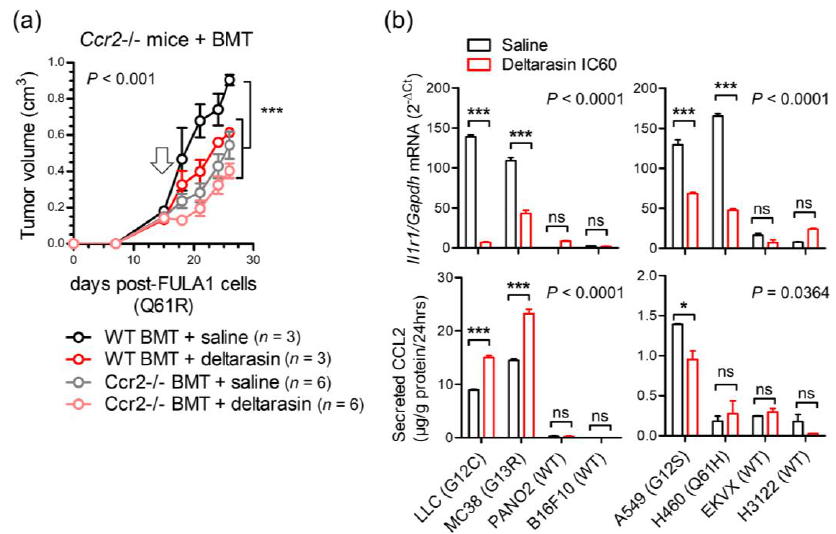
Figure 6. In vivo KRAS-dependence requires myeloid Ccr2 and is abolished by deltarasin treatment via downregulation of IL1R1 expression in KRAS -mutant cancer cells. ( a ) Total-body-irradiated (900 Rad) Ccr2 − / − mice received adoptive BMT from WT or Ccr2 − / − donors (all back-crossed > F12 to the FVB strain). After one month allowed for chimeric bone marrow reconstitution, chimeras received 10 6 syngeneic FULA1 cells ( Kras Q61R ) sc [19]. Daily ip saline or deltarasin (15 mg/Kg in saline) treatments were started when tumors > 100 mm 3 were established (arrow). Data are presented as mean ± SD. p , overall probabilities according to two-way ANOVA; ***: p < 0.001 for the indicated comparisons via Bonferroni post-tests. ( b ) Il1r1/IL1R1 mRNA expression via qPCR (top) and CCL2 protein secretion via ELISA (bottom) of mouse (left) and human (right) cancer cell lines treated with saline or deltarasin IC 60 for 72 h. Data are presented as mean ± SD. p , overall probabilities according to two-way ANOVA; ns, *, and ***: p > 0.05, p < 0.05 and p < 0.001, respectively, for the indicated comparisons via Bonferroni post-tests.